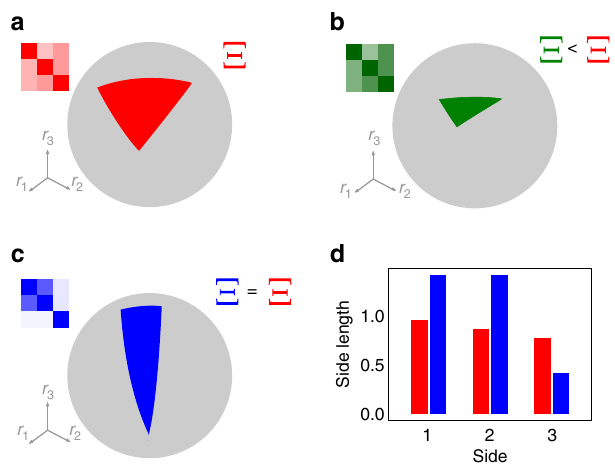
Figure 1 | Geometrical properties of feasibility. The panels show the size and shape of the feasibility domain for three interaction matrices, each defining the interactions between three populations. If r corresponds to a feasible equilibrium, so does c r for any positive c ; one can therefore study the feasibility domain on the surface of a sphere 25 (Supplementary Note 3). The grey sphere represents the S ¼ three-dimensional space of growth rates, while the coloured part corresponds to the combination of growth rates leading to stable coexistence. The area (or volume for higher- dimensional systems) of the coloured part is measured by X . Larger values of X correspond to a higher fraction of growth rate combinations leading to coexistence: the red interaction matrix (panel a ) is therefore more robust against perturbations of r than the green one ( b ). The size of this region (that is, the value of X ) does not capture all the properties relevant for coexistence. The red ( a ) and blue ( c ) systems have the same X , but the two regions—despite having the same area—have very different shapes, summarized in d , where we show the length of each side for the red and blue systems. In the red system ( a ), the three sides have about the same length, and thus moving from the centre in any direction will have about the same effect. In the blue system ( c ), however, one side is much shorter than the other two, implying that even small perturbations falling along this direction may drive the system outside the feasibility domain. One of our main results is that, roughly speaking, if the red system corresponds to the random case, then the green one to food webs (having the same heterogeneity in side lengths as the random case but with a smaller X overall), and the blue one to empirical mutualistic networks ( X rougly the same as in the random case but with the heterogeneity in side lengths much